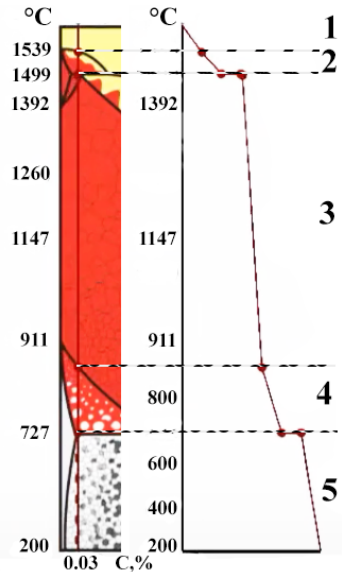
Figure 4. Cooling curve for steel with low carbon content (up to 0.03% mass): 1—there are no phase transformations, the liquid melt is cooled; 2—ferrite crystallization, the formation of δ -iron occurs, then in the region of 1499 °C the peritectic transformation δ -Fe + liquid phase → γ -Fe; 3—an γ -Fe phase is formed; 4—the formation of the γ -Fe + β -Ferrite phase occurs below a temperature of 911 °C; 5—the α -Ferrite+III Cementite phases is formed at temperatures below 727 °C.